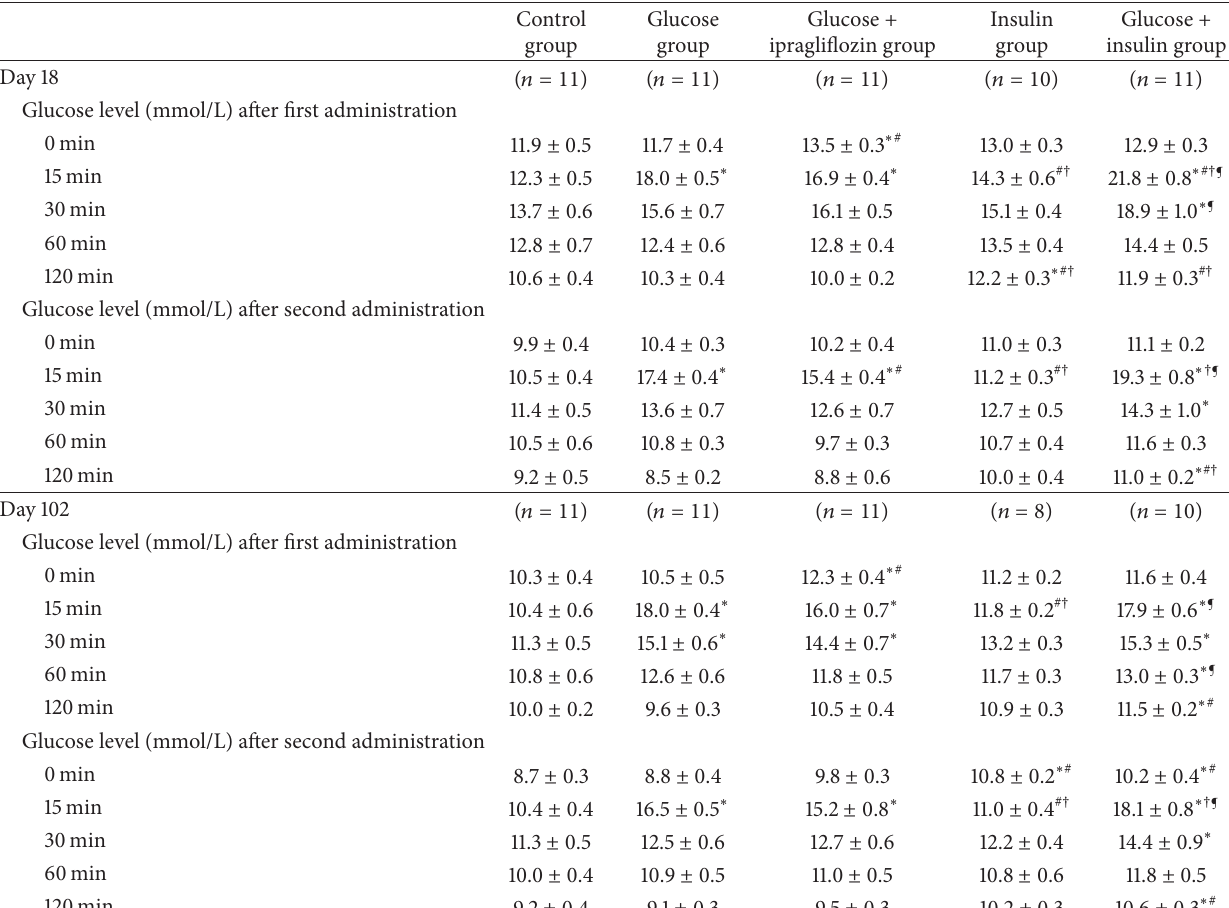
Table 2: Daily plasma glucose profile of each